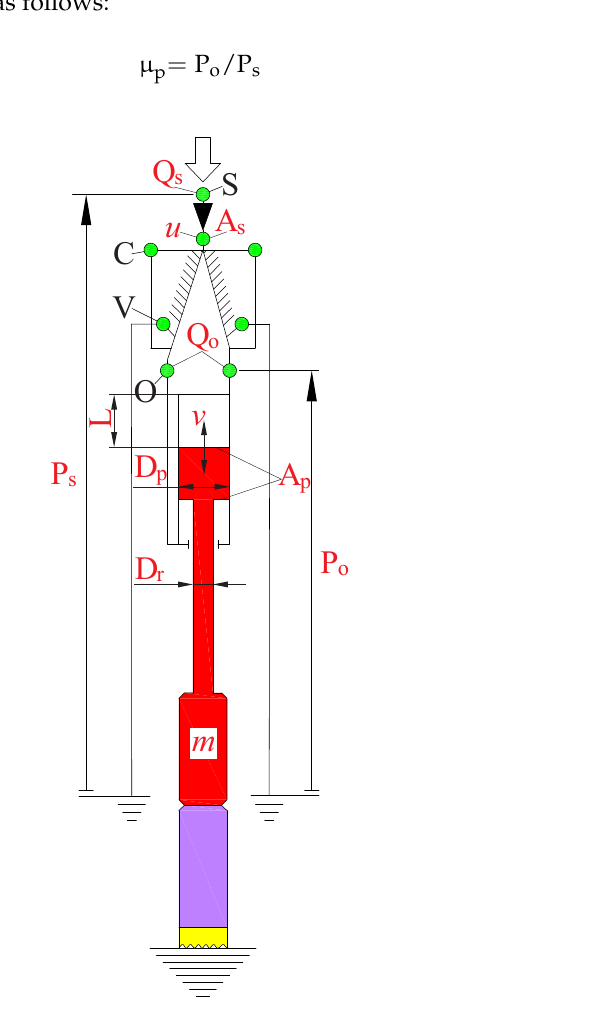
Figure 5. A schematic circuit diagram for the fluidic hammer.(S—Inlet of supply nozzle, C—Control nozzle, V—Vent, O—Output channel, P s —Pressure drop between supply nozzle and vent, P o —Pressure drop between output channel and vent, Q s —Flow rate at the inlet of supply nozzle, Q o —Flow rate at the output channel, u —Mean flow velocity in the supply nozzle, v —Moving velocity of the impact body, A s —Sectional area of the supply nozzle, A p —Action area of the piston, D p —Diameter of the piston, D r —Diameter of the piston rod, m —Mass of the impact body, L —Stroke of the impact body).